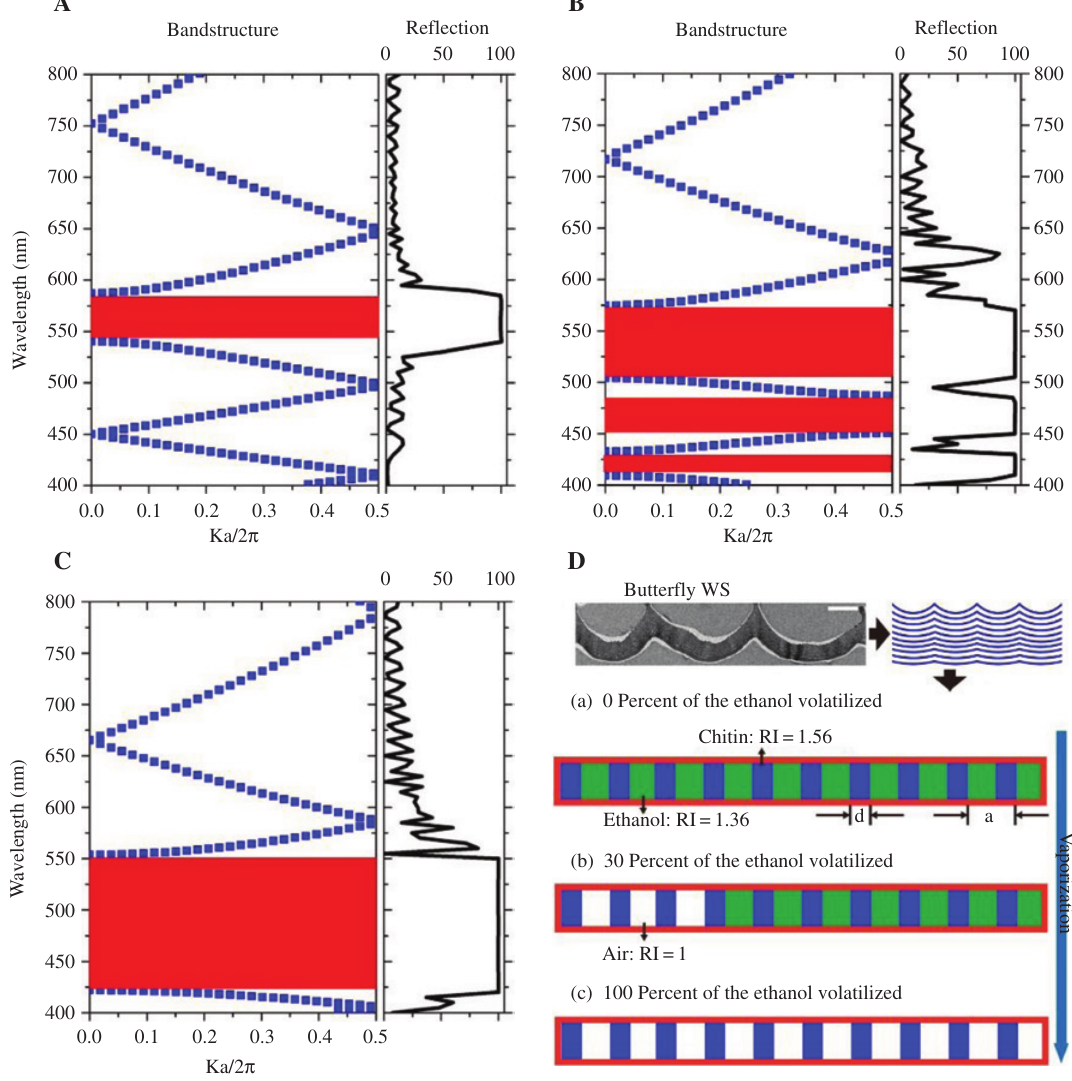
Figure 8: Band diagram and corresponding reflection with volatilization of the ethanol in Papilio ulysses PC structure, simplified 1D model was applied here. (A) Zero percent of the ethanol volatilized. (B) Thirty percent of the ethanol volatilized. (C) One hundred percent of the ethanol volatilized. (D) Schematic plot of the PC model used in (a, b, c). Zero percent, 30%, and 100% of the ethanol volatilized, respectively. The refractive index of the chitin: 1.56; the refractive index of ethanol: 1.36; the refractive index of the air: